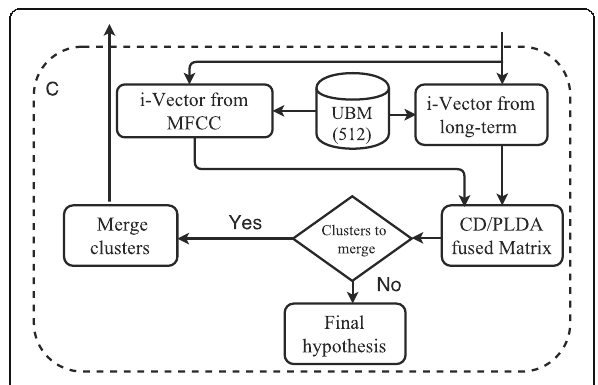
Fig. 5 Proposed i-vector-based clustering architecture. The proposed i-vector-based cosine-distance and PLDA clustering are based on short- and long-term speech